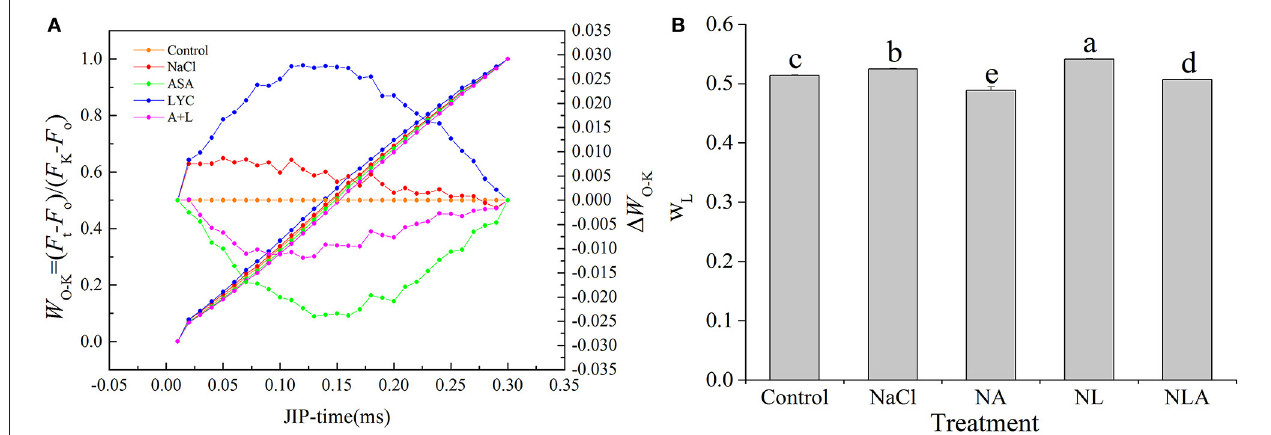
FIGURE 6 | Shape of the prompt fluorescence (PF) transient curves normalized between O and K steps expressed as W O − K = [( F t − F o )/( F K − F o )], 1 W O − K = W O − K (stress)– W O − K (control) (A) , W L = [( F L − F o )/( F K − F o )] (B) in leaves of salt-stressed tomato seedling with or without exogenous reduced ascorbic acid (AsA) and lycorine (LYC) spraying. Values are means ± SD ( n = 3). Different letters (a, b, c, d, and e) indicate significant difference at P < 0.05 among treatments. Error bar is smaller than the line at the top of the graph. Control, no added NaCl, no sprayed AsA and LYC; NaCl, added 100 mmol/L NaCl; NA, added 100 mmol/L NaCl and sprayed 0.5 mmol/L AsA; NL, added 100 mmol/L NaCl and sprayed 0.25 mmol/L LYC; NLA, added 100 mmol/L NaCl and sprayed 0.25 mmol/L LYC and 0.5 mmol/L AsA.